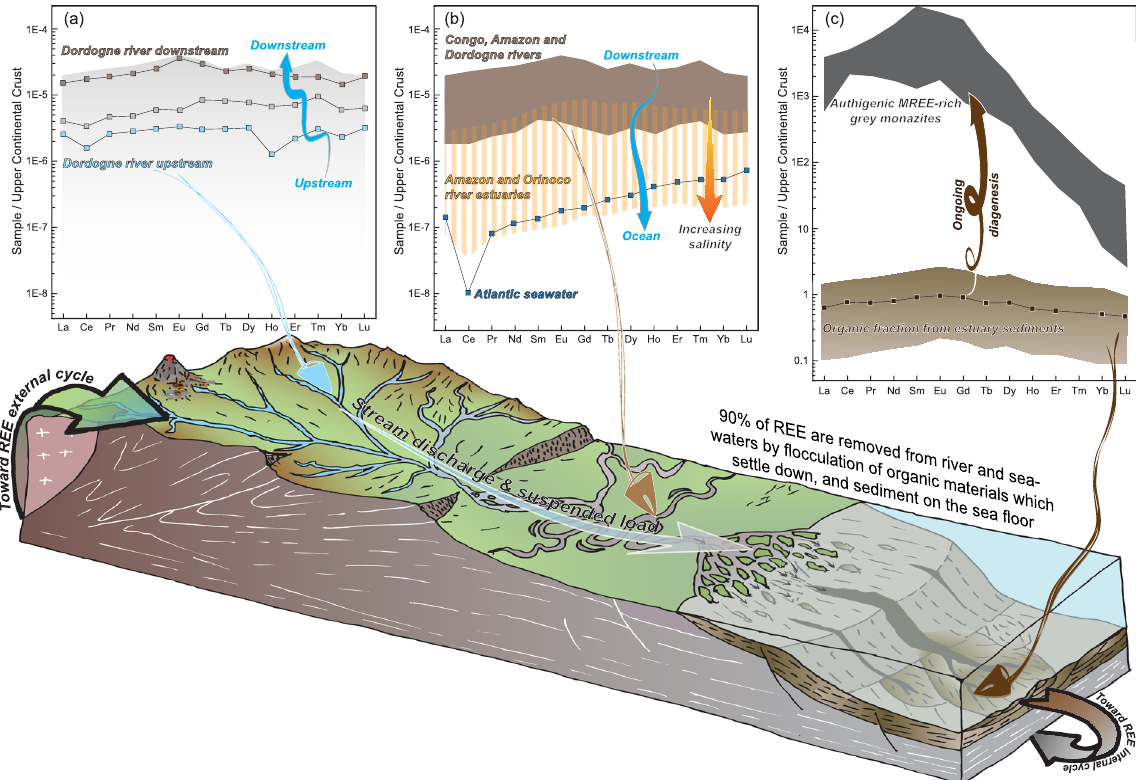
Figure 2. Sketch illustrating the REE external cycle and summarizing the processes responsible for REE fractionation from river water to organic sediments. UCC-normalized REE patterns are detailed in Fig. 1, and Atlantic seawater is from Freslon et al . 20 . UCC-normalized patterns for ( a ) river water, ( b ) river, estuarine and seawater, and ( c ) sedimentary organic matter and authigenic monazites.